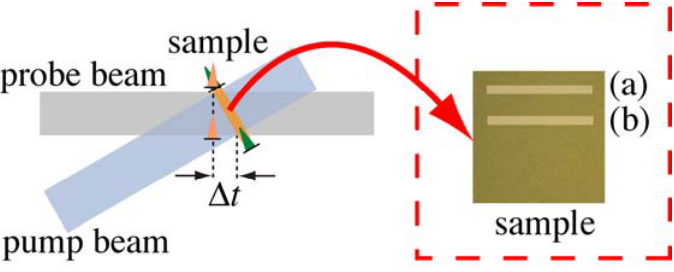
Figure 11. Schematic optical apparatus around the sample position for the time-frequency 2D pump-probe imaging spectroscopy applicable to solid-state samples.